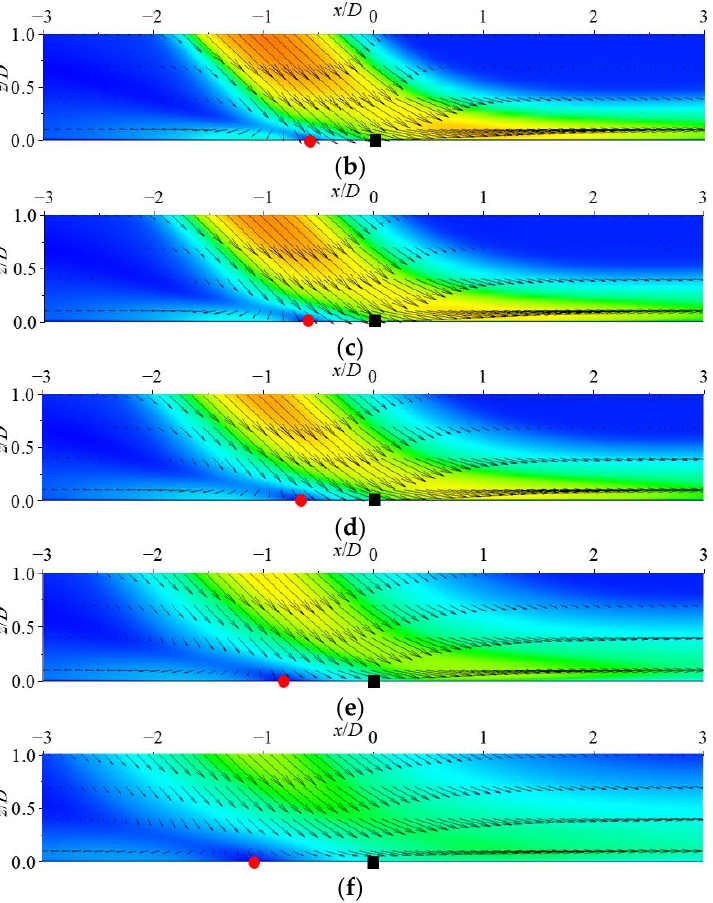
Figure 11. Mean velocity vectors in the near-wall region and flood contours of the normalized mean axial velocity V/V b : ( a ) H/D = 1; ( b ) H/D = 2; ( c ) H/D = 3; ( d ) H/D = 4; ( e ) H/D = 6; ( f ) H/D = 8. The horizontal distance between SP and GC is represented by L sp . Figure 12 shows the L sp /D distribution at different impinging heights. When H/D ≤ 3, L sp /D decreases slightly from 0.62 and then increases to 0.6, and the size difference of L sp /D under different levels of Re is small. When H/D > 3, the value of L sp /D gradually increases with the increase in H/D . When Re = 11,700, L sp /D is larger than when Re is higher.